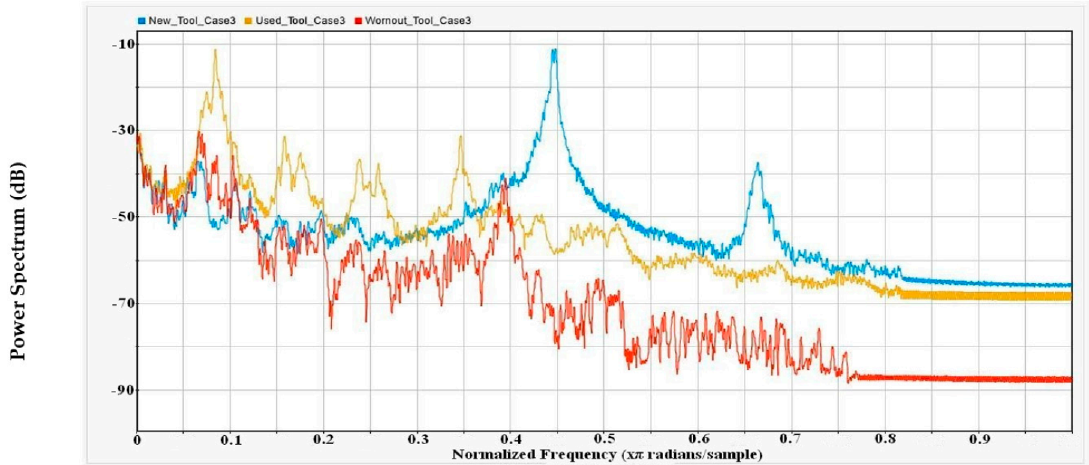
Figure 18. Power spectral density (PSD) for Case-3 of new (blue), used (yellow), and worn-out (red) tool with maximum leakage settings.